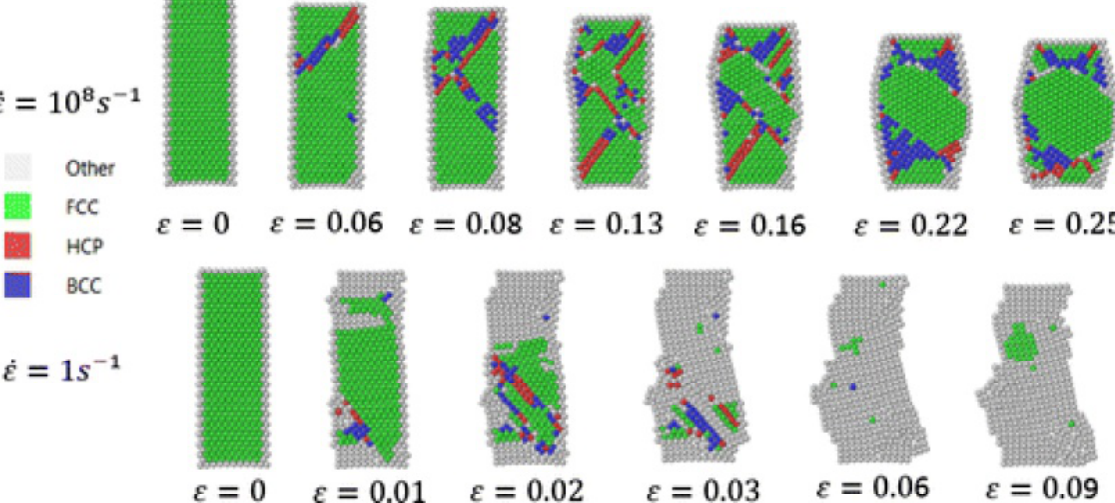
Fig. 22. Structure evolution of Ni nanoslab under compression at high strain rate (top row) and low strain rate (bottom row). For the case of high strain rate deformation, the structure experiences the appearance of shear band, the partially rotation of crystal orientation, and a barrel-shaped structure. For the low strain rate deformation, amorphization starts from the top and bottom surfaces and is followed by material extrusion from the free surfaces. Reprinted with permission from Yan X, Sharma P. 2016. Time-Scaling in Atomistics and the Rate-Dependent Mechanical Behavior of Nanostructures. Nano Letters 16, [235]: © 2016 ACS Publications.